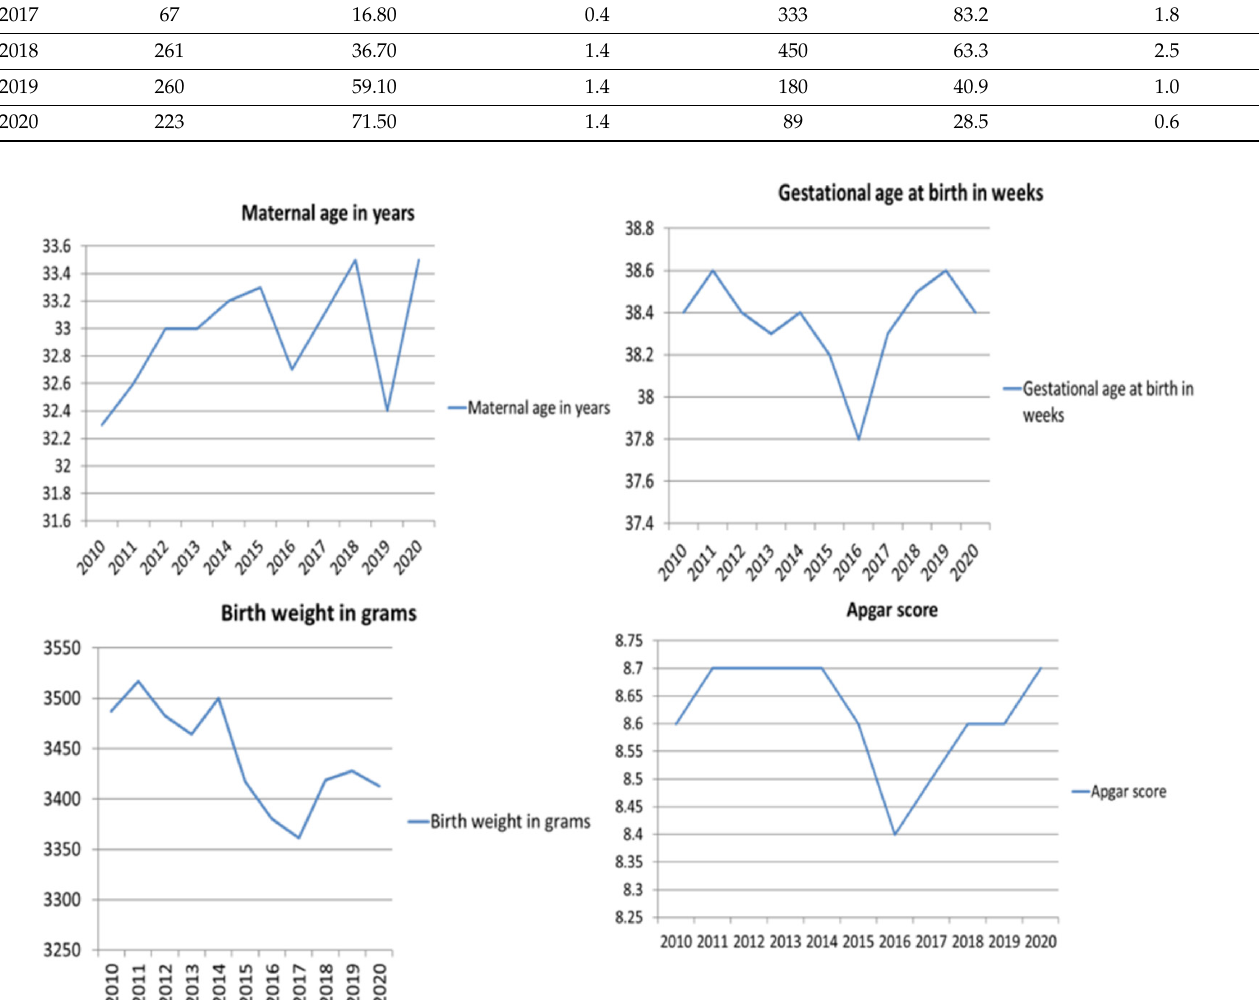
Figure 2. The trends in the maternal age, gestational age at delivery, newborns’ birth weight and Apgar scores in the study period.